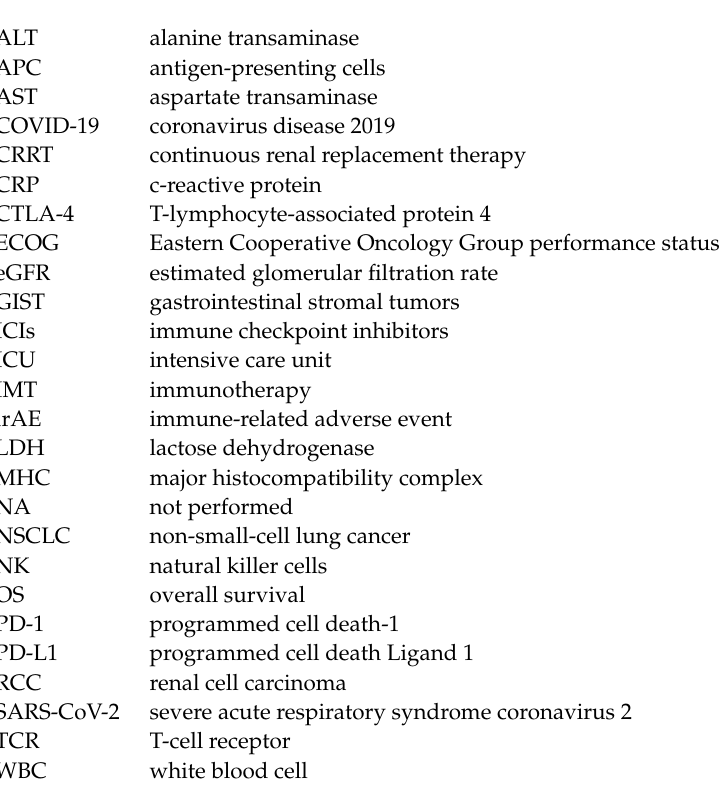
Table S2: Characteristics of the Sample, COVID Infected, all Cancers ( n = 121); Table S3: Association between Clinical Factors and Smoking Status, COVID Infected ( n = 121); Table S4: Association between Clinical Factors and Covid Vaccine Status, COVID Infected ( n = 121); Table S5: Risk Factors of Admission, ICU, and Mortality, COVID Infected ( n =